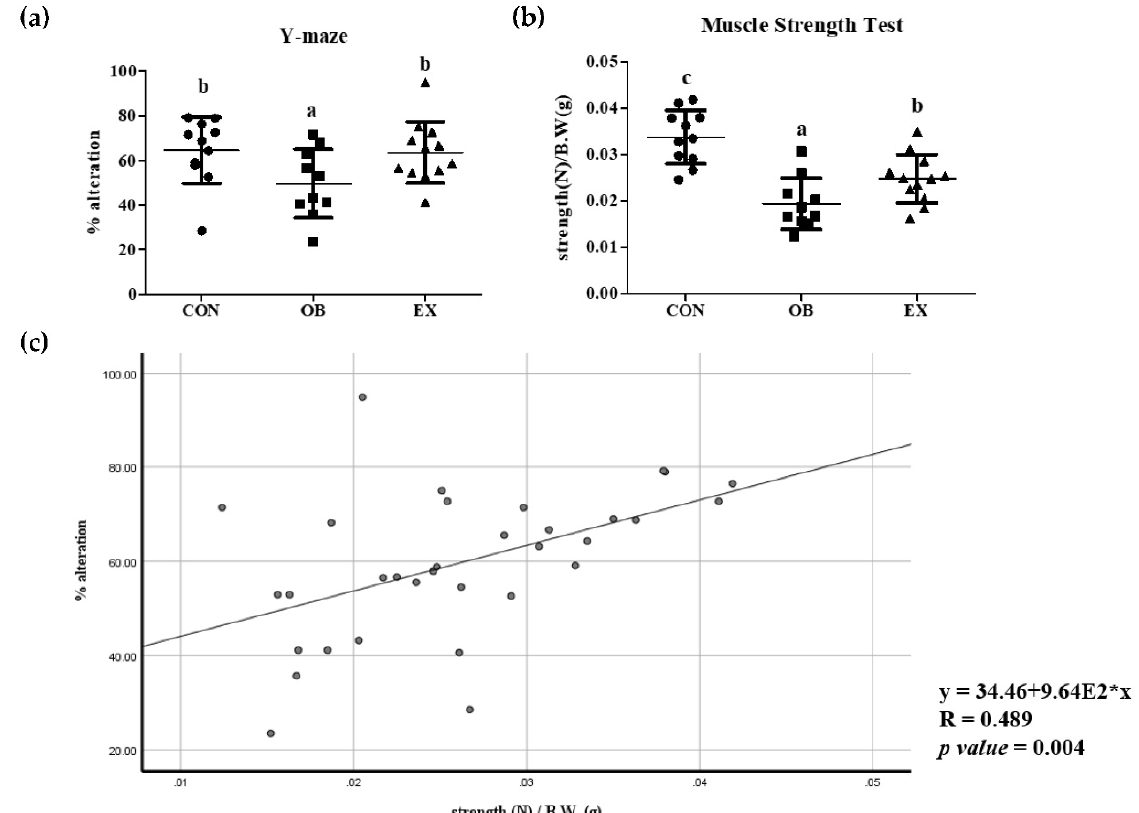
Figure 3. Effects of resistant exercise on ( a ) cognitive and ( b ) muscle function, and ( c ) correlation between cognitive and muscle functions. Values are means ± SD ( n = 10~12). Mean values with the same superscript letter (a, b and c) are not significantly different ( p < 0.05). *: multiply.